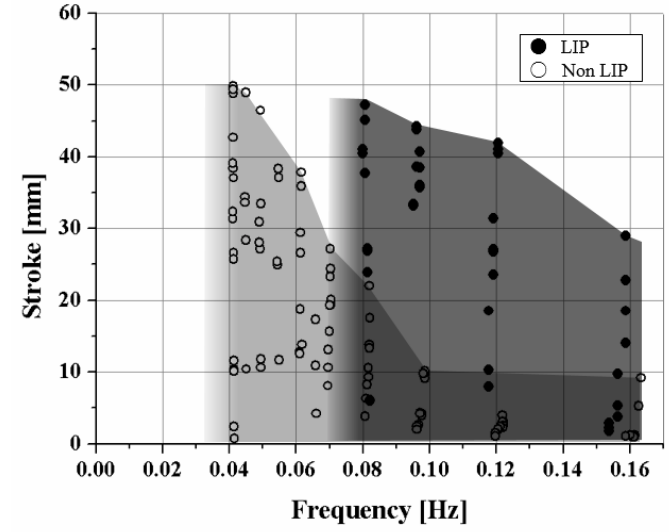
Figure 10. Stroke versus frequency graph merging the experiments with various heating and cooling times. The graph shows the maximum frequency of two SMA coil spring actuators that can produce a full stroke.